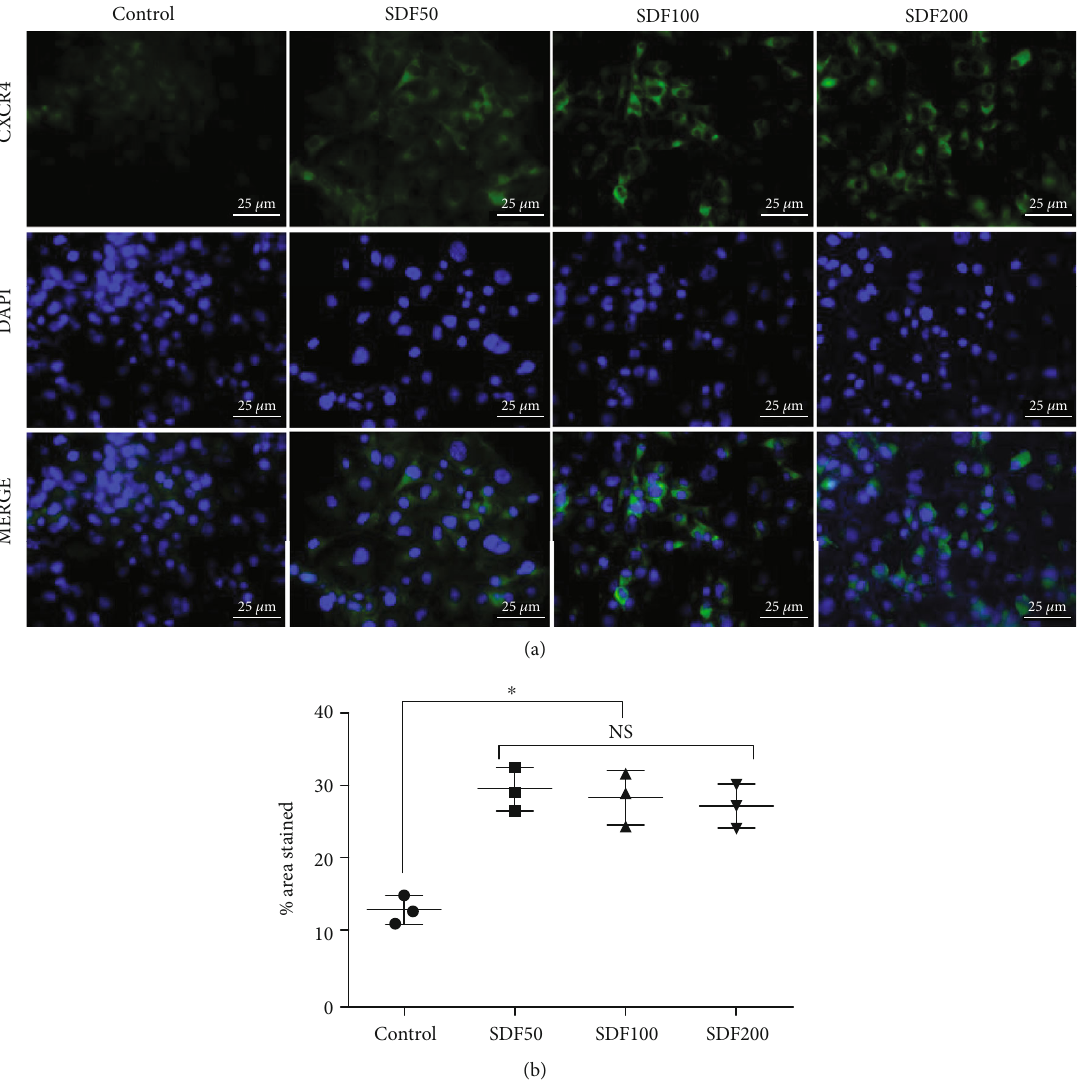
Figure 4: CXCR4 immuno fl uorescence staining of rat BMSCs. (a) CXCR4 immuno fl uorescence staining after 96 hours of coculture with SDF-1 α /OPF/BP composites. (b) The percentage of CXCR4-positive areas of the SDF200, SDF100, and SDF50 groups was signi fi cantly higher ( ∗ p < 0 : 05 ) than that of the control